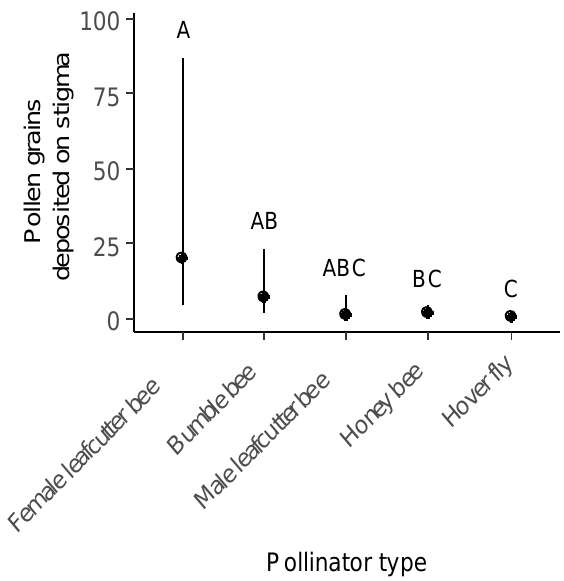
Figure 5. The effect of pollinator type on the number of pollen grains deposited on stigmas of canola flowers. The types of pollinators included female leafcutter bees ( N = 20), bumble bees ( N = 13), male leafcutter bees ( N = 6), honey bees ( N = 43), and hover flies ( N = 21). Points represent the model-adjusted means and lines represent the 95% CI. Letters indicate significant differences among means ( P < 0.05); means followed by a common letter are not significantly different at the 5% level of